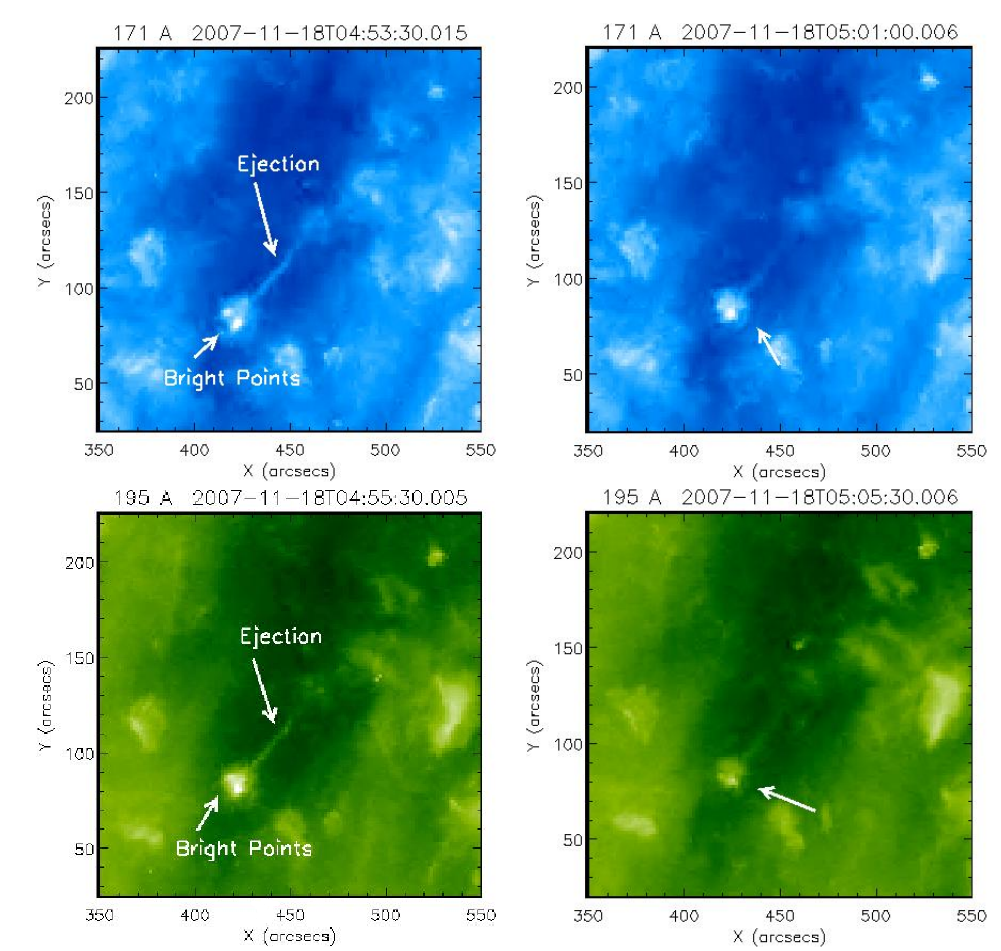
Fig. 8. A blow up of the “Eiffel Tower” jet shown in Fig. 7.